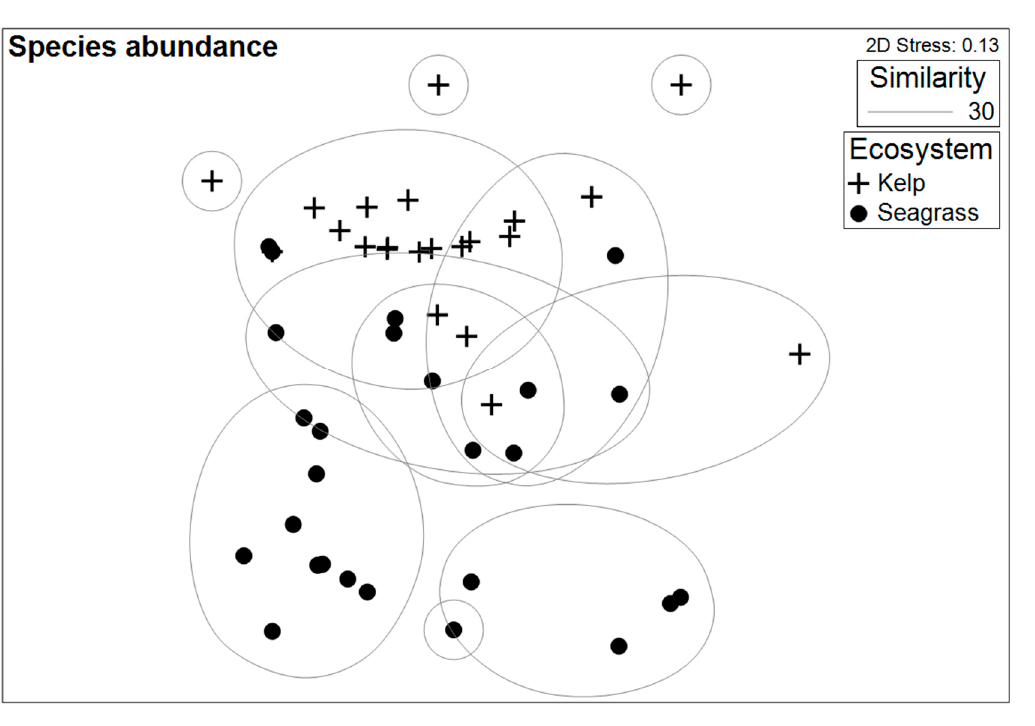
Figure 4. Non-metric multidimensional scaling configuration with superimposed Bray-Curtis similarity clusters (30% similarity) for fish assemblage in seagrass and kelp ecosystems across the west coast of the UK. One anomalous seagrass sample was removed from the MDS plot for clearer aesthetics. One conger eel and no other fish were identified in this sample.